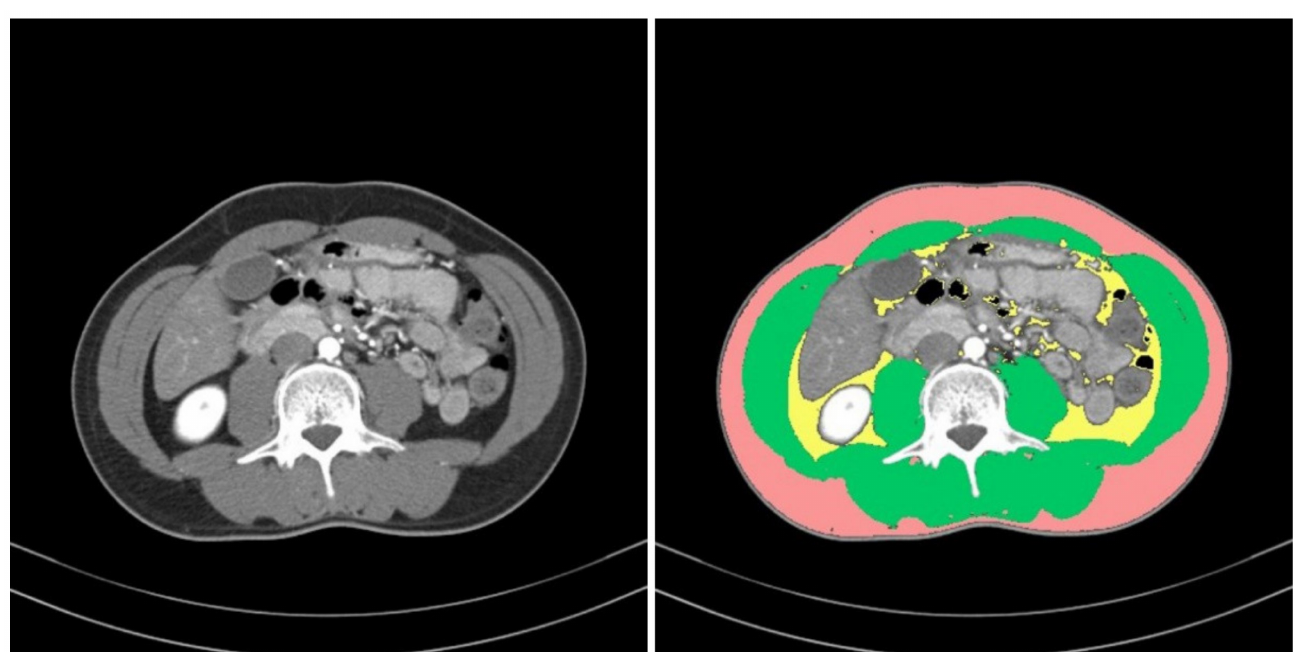
Figure 2. Areas of body components identified by Gachon_DeepBody: muscle ( green ), subcutaneous fat ( red ), visceral fat ( yellow